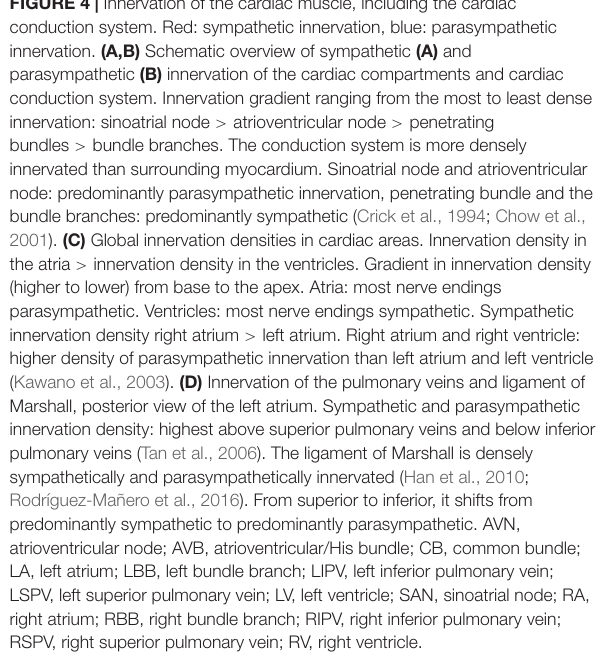
nerves are equalized. In the elderly, there is a decline in